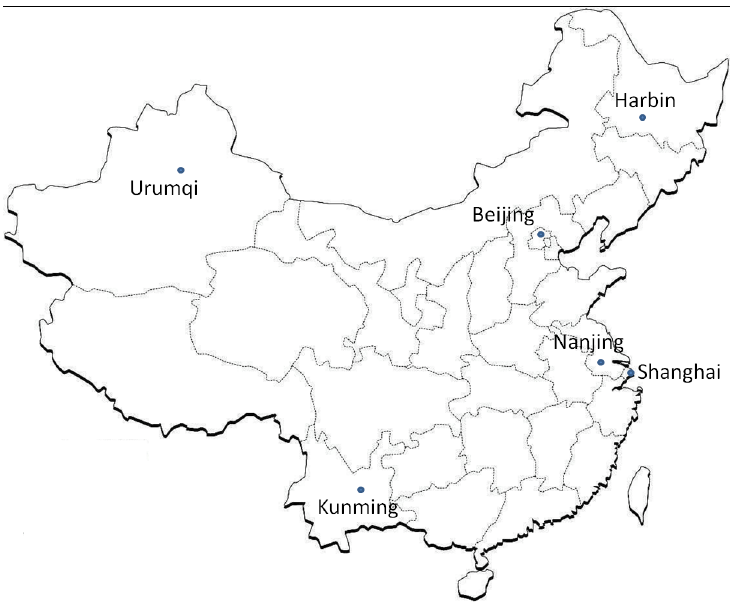
Fig 1. Locality map of different cities included in this study. A total of 835 samples from pediatric patients presenting with the symptoms of respiratory tract infection (RTI) belonging to five different geographical locations in China were collected from January to December 2016. Two-hundred-and-forty-three samples were from Beijing, which is located in mid-north China; 100, from Shanghai, located in the east; 275, from Kunming, Yunnan province, located in the south; 140, from Harbin, Heilongjiang province, located in the north; and 72, from Urumqi, Xinjiang province, located in the west. Ten M . pneumoniae -positive DNA samples isolated from 10 clinical specimens were collected from pediatric patients in Nanjing, which is close to